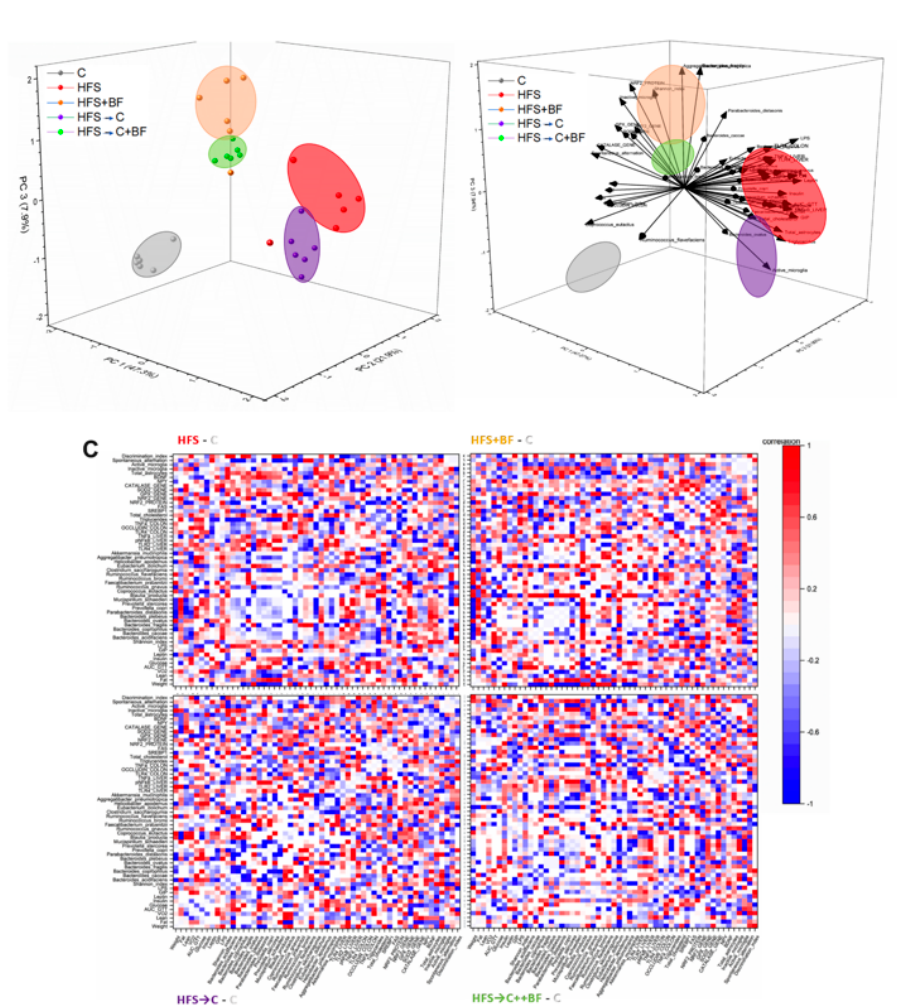
Figure 12. Association between biochemical parameters in liver and brain with the gut microbiota. ( A ) PCA_scores: Principal components 1, 2, and 3. Each dot corresponds to each subject, ellipse is the best fitting for each group (which includes 80% of the data). ( B ) Loading plot. Vector of each data variable on the first three principal components. Each ellipse corresponds to each group studied, ( C ) Correlation_difference. Normalized differences between correlation matrix of each group minus the C group correlation matrix of all the variables. White corresponds to the same correlation between variables, red is maximum change, and blue indicates negative